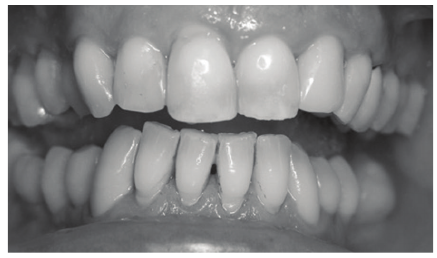
Figure 1: Ultrasonic debridement has been